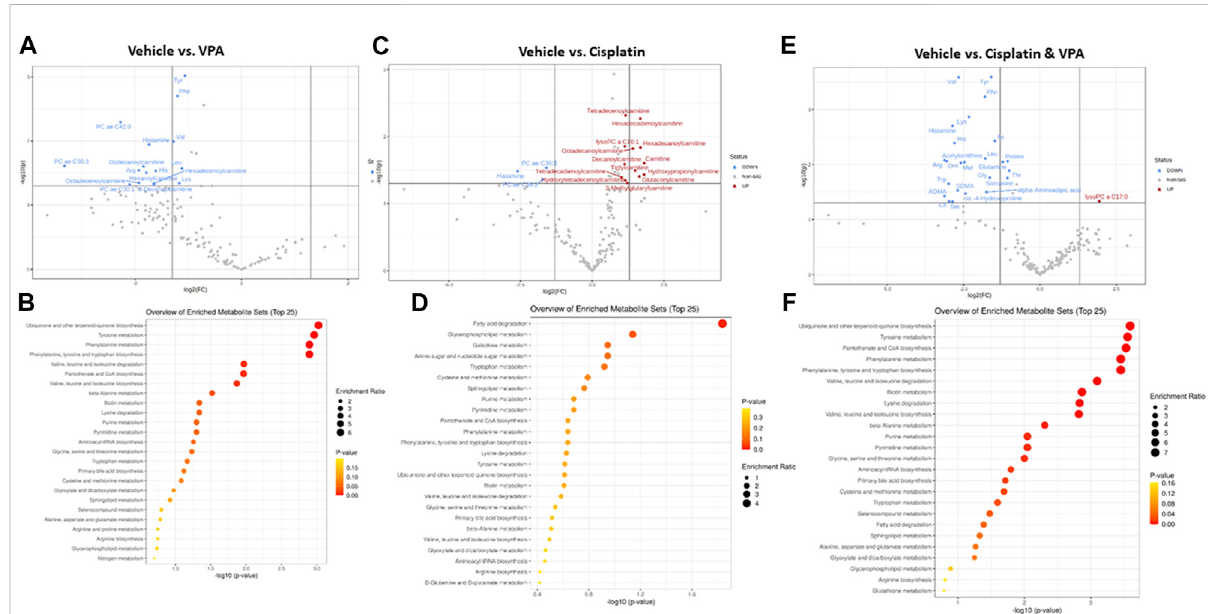
FIGURE 3 Speci fi cmetabolitealterations andmetabolic setenrichmentanalyses (MSEA). Volcanoplots withannotated metabolites thatweresigni fi cantly alteredinMDA-MB-231cellsfollowing72 htreatmentwith (A) VPA, (B) Cisplatin, (C) Cisplatin&VPA,allcomparedtocontrols.Thereddotsrepresent metabolitesabovethethreshold.Thebluedotsrepresentmetabolitesbelowthethreshold.Thefurtherthemetabolite ’ spositionawayfromthe(0,0) coordinate, the more in fl uenced it is by the treatment. Volcano plots show the − log10 FDR-adjusted p -values and log2 fold-changes. Metabolites with adjusted p -values less than 0.05 and afold-change greater than 2-fold or lessthan ½-foldare highlighted and labeled. MSEA